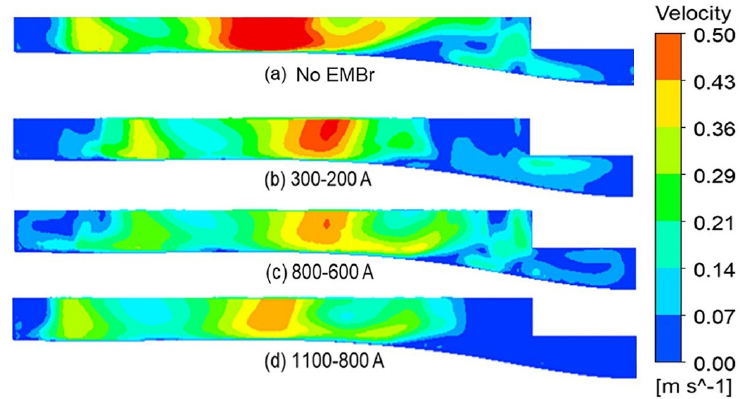
Figure 13. Funnel mold surface velocity distribution.